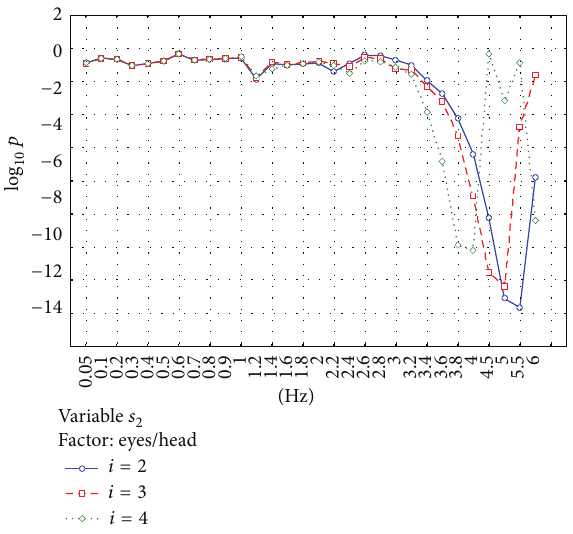
Figure 7: Analysis of the parameter 𝑠 2 . The figure shows the statistical significance 𝑝 of the main effect in MANOVA analysis for the factor “eyes/head state.” The differences between registration conditions are especially visible for the high-pass filters 𝑓 ≥ 3.4 Hz.